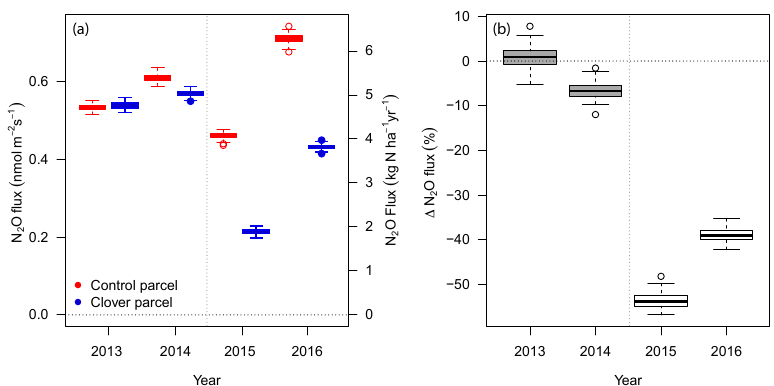
Figure 6. (a) Annual N 2 O exchange at the control (red) and clover parcels (blue) for the reference years 2013–2014 and the experimental years 2015–2016. (b) Relative differences between N 2 O exchange in the control and clover parcels for the reference years (grey) and the experimental years (white). Boxes indicate the interquartile range based on non-parametric bootstrapping; bold black lines within boxes indicate the